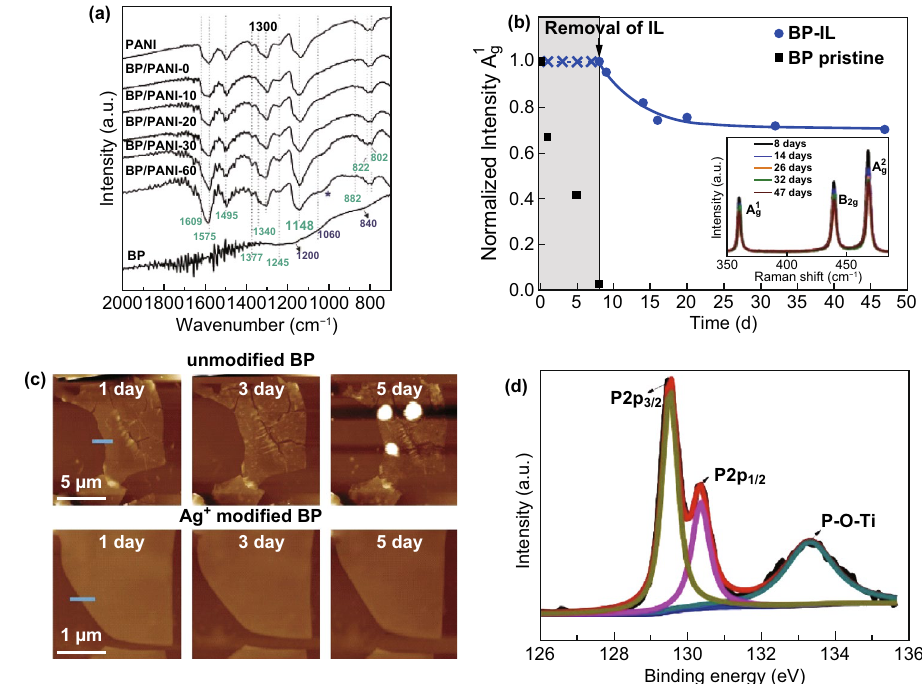
Fig. 6 a FTIR spectra of BP@PANI under different exposed time [115]. b The evolution of Raman normalized peak A g1 of BP-IL and pristine BP with time [97]. c AFM image of unmodified BP and Ag + modified BP under different air exposed time [49]. d XPS of BP/Ti 3 C 2 heterostruc- ture [117]. Adapted from Refs. [49, 97, 115, 117] with